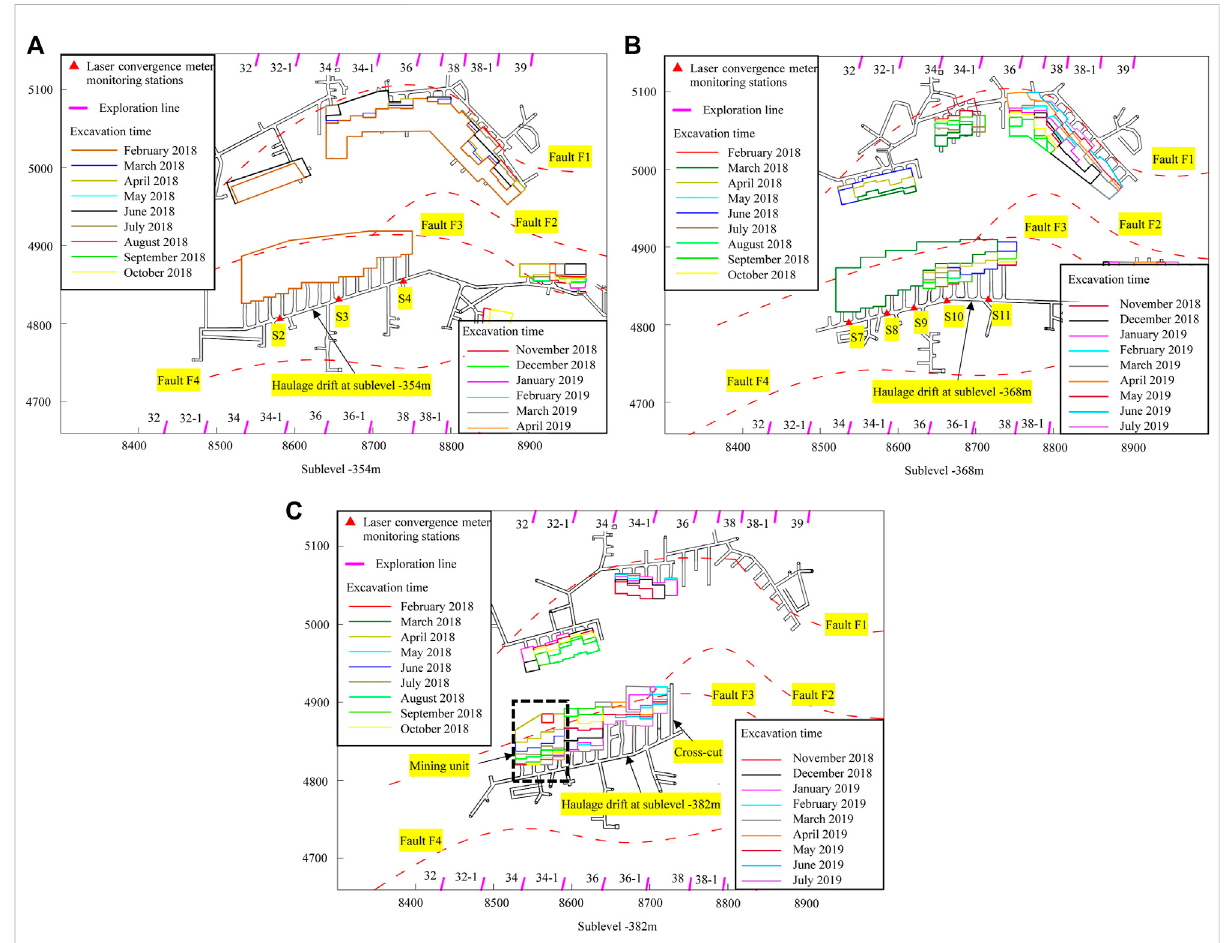
FIGURE 3 Planar projection of the laser convergence meter monitoring stations and the mined-out areas. (A) Sublevel -354 m. (B) Sublevel -368 m. (C) Sublevel -382